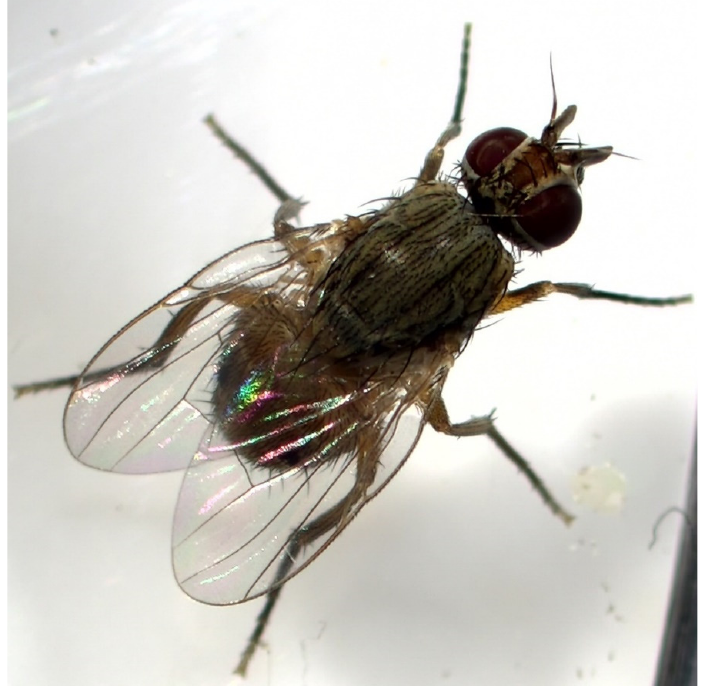
Figure 2. Adult Atherigona orientalis .